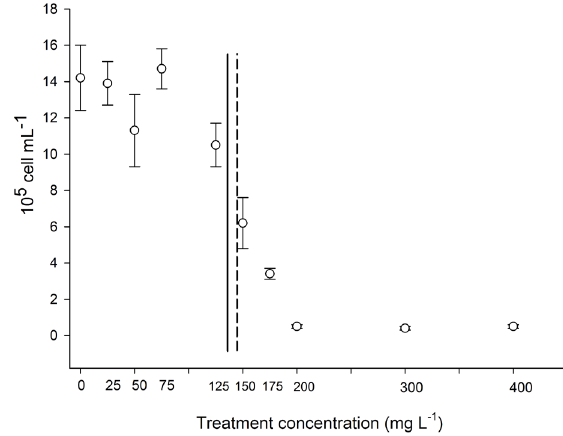
Figure 2 - Raphidocelis subcapitata culture density (cell mL - 1 ) at 96 h of exposure as function of extract concentration of Annona glabra (mg L -1 ). Continuous line represents the half maximal inhibitory concentration (IC ) at 72 h; dashed line 50 represents IC at 96 50